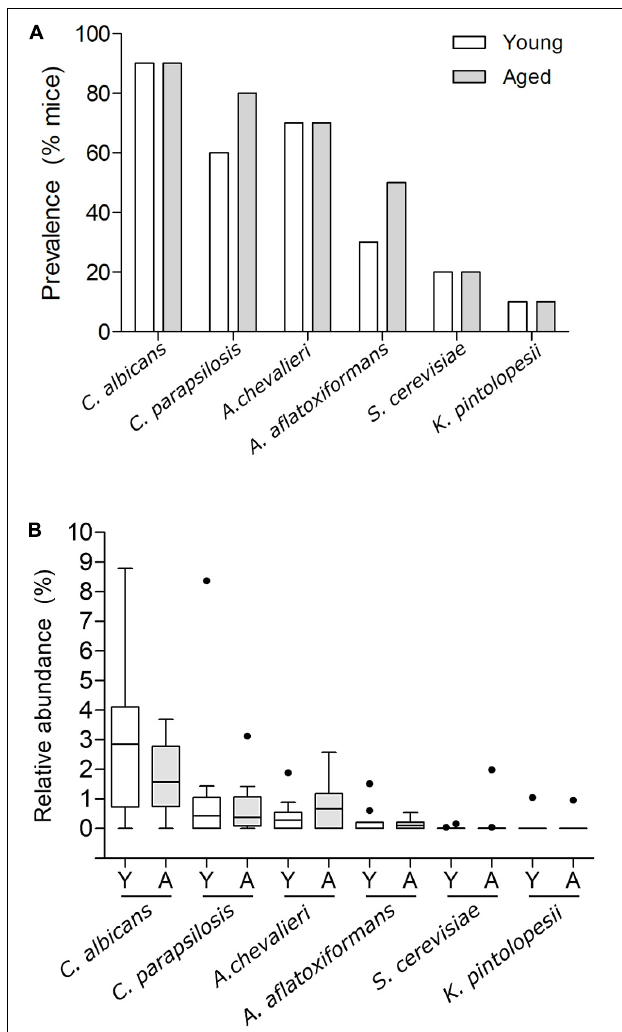
FIGURE 5 | Prevalence and relative abundance of putative gut commensal fungal species in faecal samples of young vs. aged SPF mice. (A) Prevalence of putative gut commensal fungal species Candida albicans , Candida parapsilosis, Aspergillus chevalieri , Aspergillus aflatoxiformans , Saccharomyces cerevisiae , and Kazachstania pintolopesii in faecal samples from groups of young and aged SPF mice ( n = 10/group), percentage of mice harbouring each species displayed as % prevalence. (B) Percentage relative abundance of those same species in faecal samples from aged (A) vs. young (Y) mice ( n = 10/group), Tukey whiskers, horizontal bars show the mean, outliers displayed as round